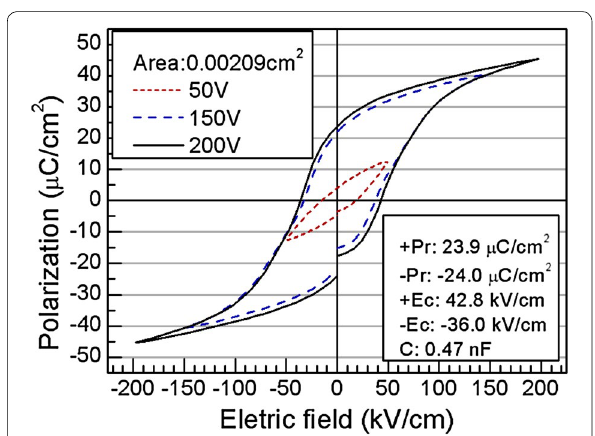
Fig. 5 Polarization curve measured by Precision LC system of the PZT thin film with IrO x inter-digitally shaped electrodes formed onto the rectangular shaped Polyimide cantilever